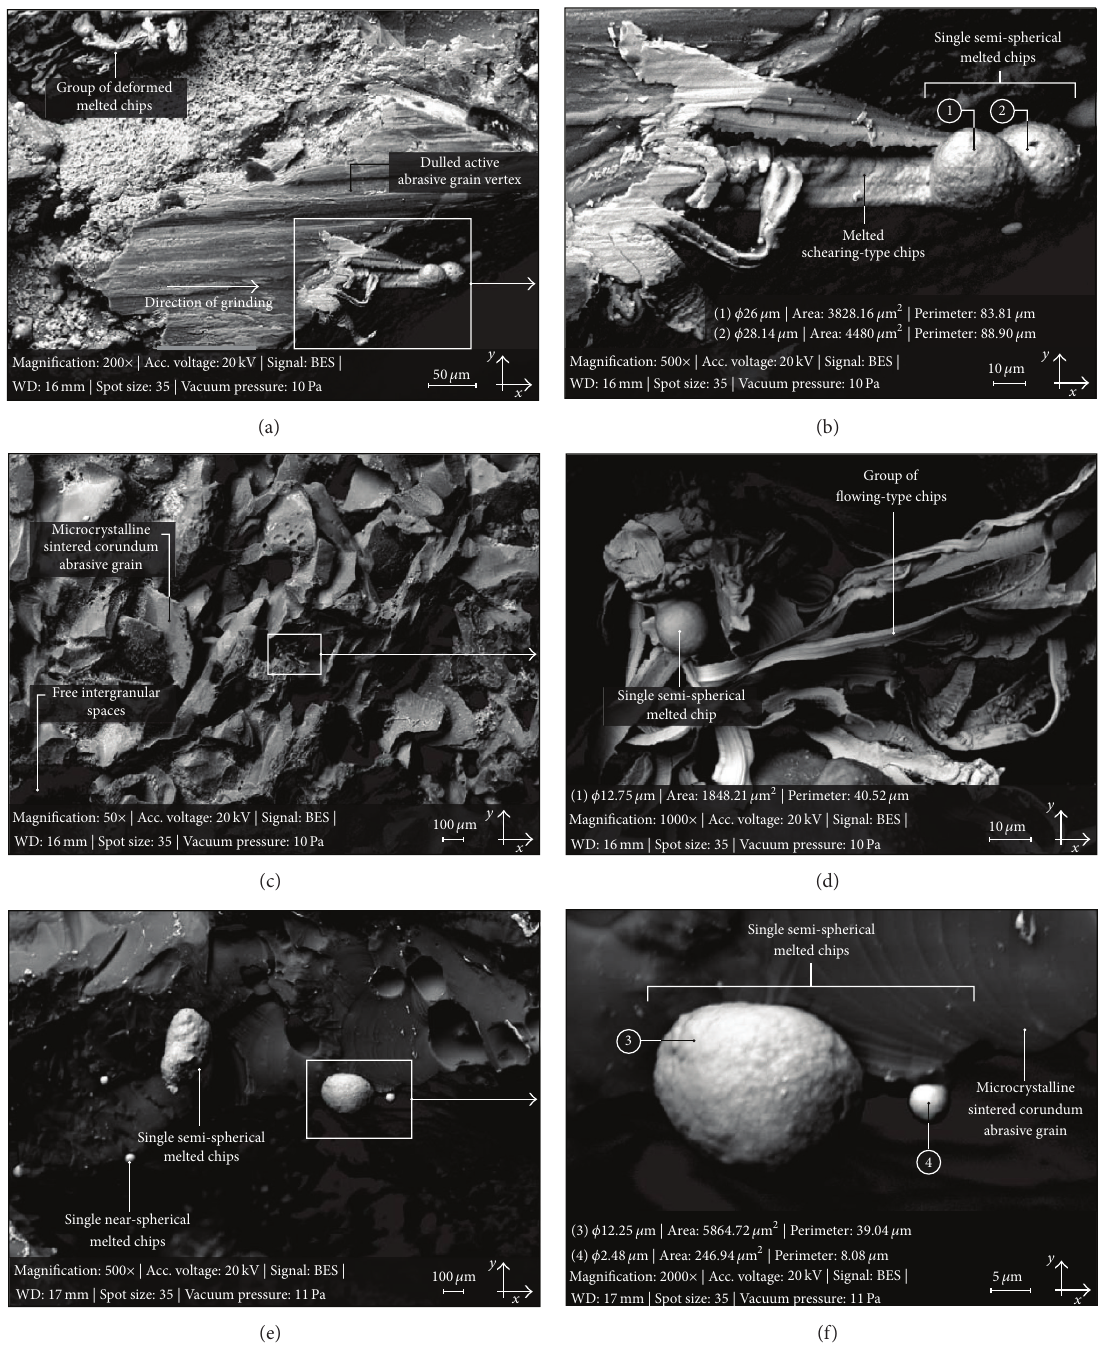
Figure 6: General morphology of semispherical melted chips formed after internal cylindrical grinding (carried out in various kinematic variations) of 100Cr6 steel obtained by use of scanning electron microscope JSM-550LV produced by JEOL: (a) SEM micrograph (size: 543.20 × 403.08 𝜇 m, mag. 200 × ) of GWAS 1–35 × 20 × 10-SG/F46K7VTO after internal cylindrical traverse grinding of 100Cr6 steel, showing two forms of spherical melted chips which formed and bonded with dulled abrasive grain vortex, (b) AOI (size: 170.37 × 12.30 𝜇 m, mag. 500 × ) extracted from (a), (c) SEM micrograph (size: 2514.28 × 1917.14 𝜇 m, mag. 500 × ) of the GWAS 1–35 × 20 × 10-SG/F46K7VTO after internal cylindrical plunge grinding of 100Cr6 steel, showing concentration of random-kind chips in free intergranular space between SG abrasive grains, (d) AOI (size: 222.85 × 165.71 𝜇 m, mag. 1000 × ) extracted from (c), (e) SEM micrograph (size: 258.82 × 194.41 𝜇 m, mag. 500 × ) of the GWAS 1–35 × 20 × 10-SG/F46K7VTO after internal cylindrical plunge grinding of 100Cr6 steel, showing various sizes of single semispherical melted chips on SG abrasive grain, and (f) AOI (size: 53.52 × 39.70 𝜇 m, mag. 2000 × ) extracted from (e). Note: Acc. voltage, accelerating voltage; BES, backscattered electron (shadow image); WD, working